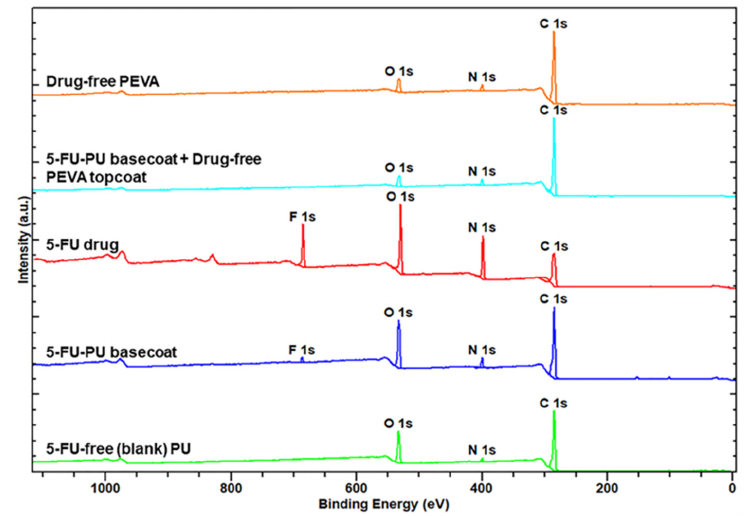
Figure 4. X-ray photoelectron spectra of 5FU and polymer coatings as indicated.